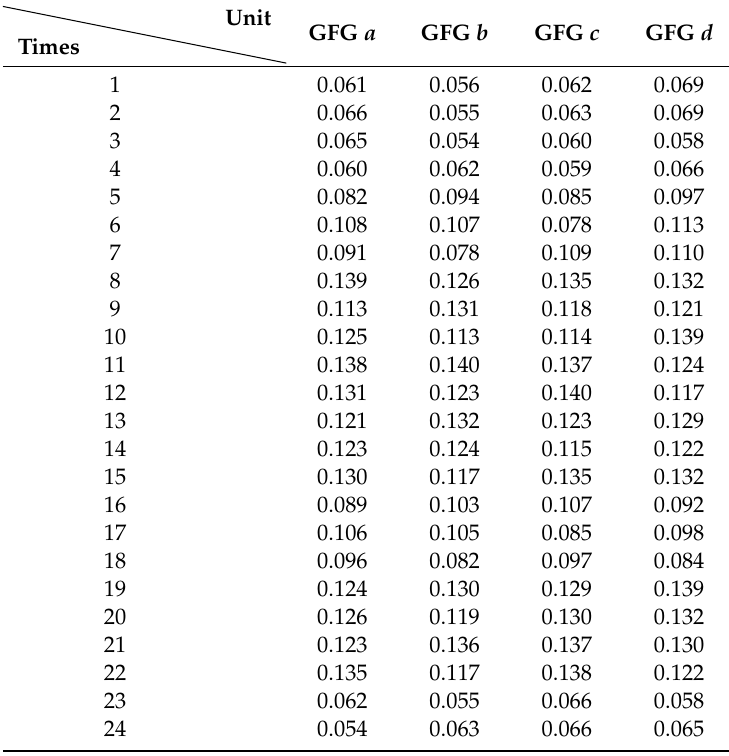
Table 6. gas-fired generators’ (GFGs’) day-ahead quotations for peak regulation (Unit: $ / kW ·